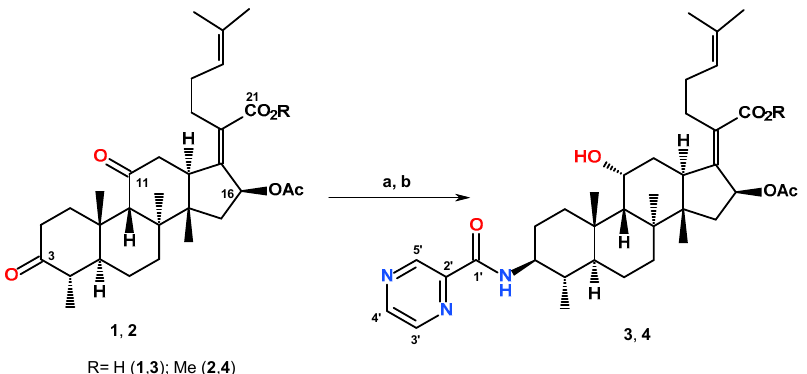
Figure 1. Structures of 11-oxo-3 β amino and 11 α -hydroxy-3 β amino derivatives of fusidane triterpe- noids.